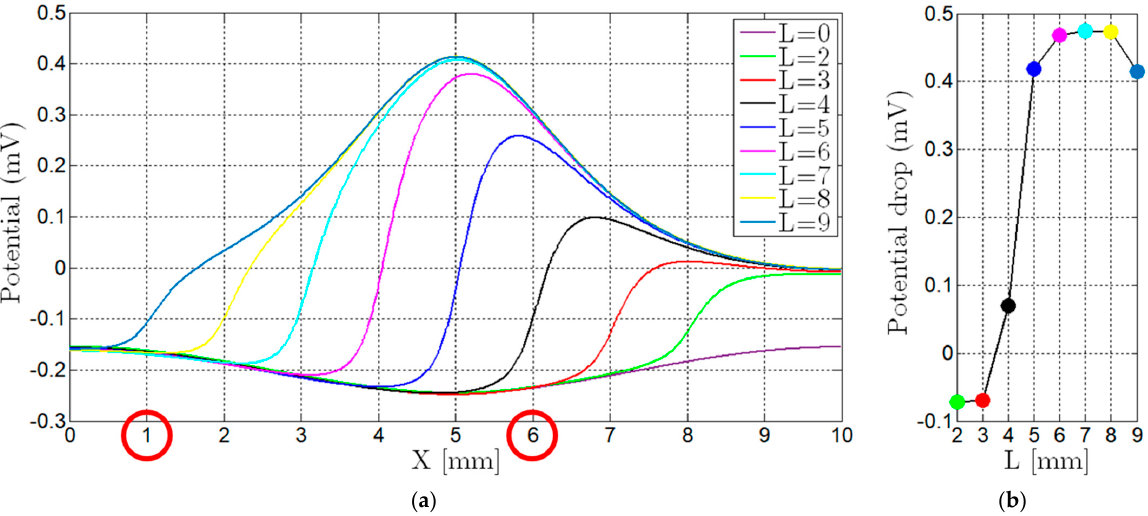
Figure 9. Numeric simulation results. ( a ) Potential distribution along the blue longitudinal line from Figure 8 with the increase of the defect length L from Figure 7. The positions 1 and 6 correspond to the overall maximum potential drop for the different defect’s lengths; ( b ) potential drop between the two chosen pin locations for different defect lengths L.